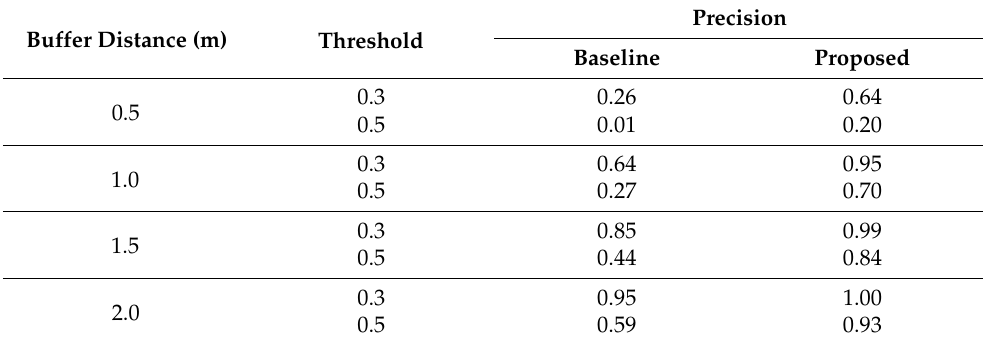
Table 3. Evaluation results for landslide trail extraction in study area B, bold denotes the best results for each